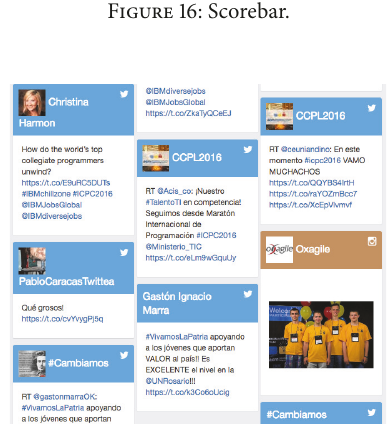
Figure 17: Kiosk content I.